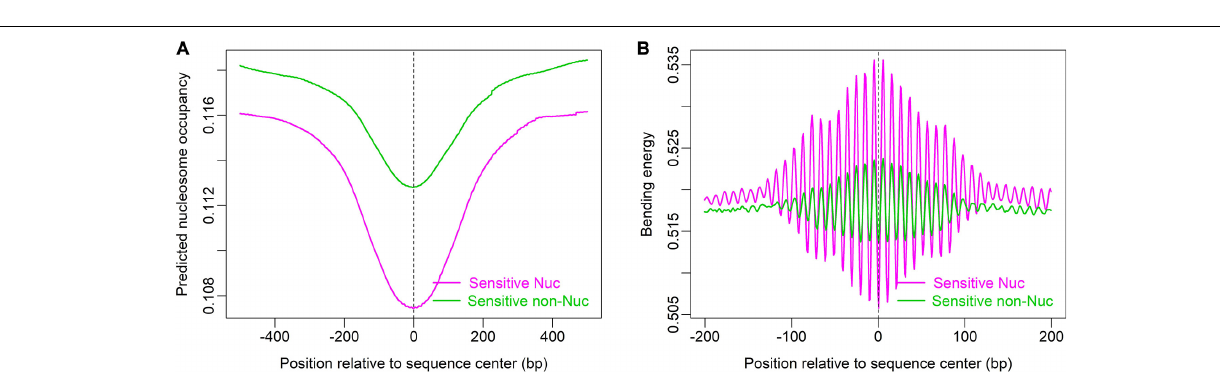
Frontiers in Cell and Developmental Biology | www.frontiersin.org